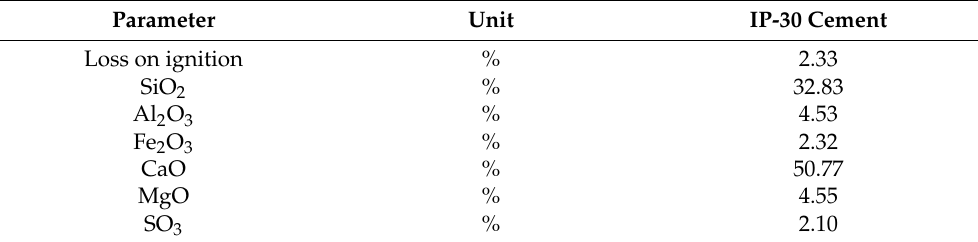
Table 1. Chemical analysis for IP-30